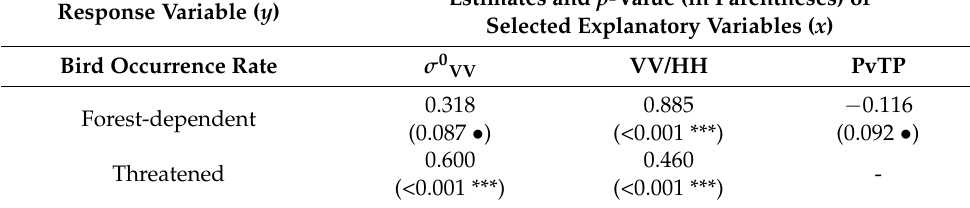
Table 5. The results of multivariate generalized linear model (GLM) analysis between the polarimetric parameters (explanatory variables) and bird occurrence rate of forest-dependent and threatened species (response variables). Estimates and p -values (in parentheses) were shown for AIC-selected variables. A hyphen “-” indicates variables not selected. Significance levels are denoted as